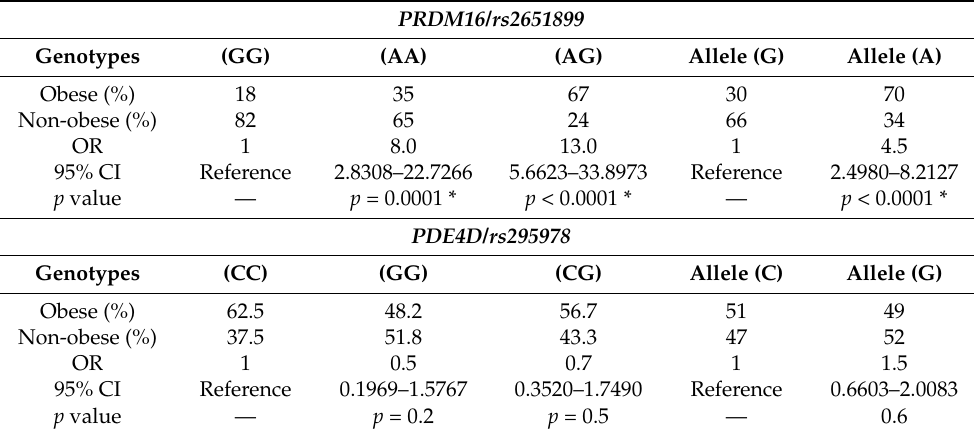
Table 2. Association of PRDM16/rs2651899 and PDE4D/rs295978 genotypes and alleles with risk of